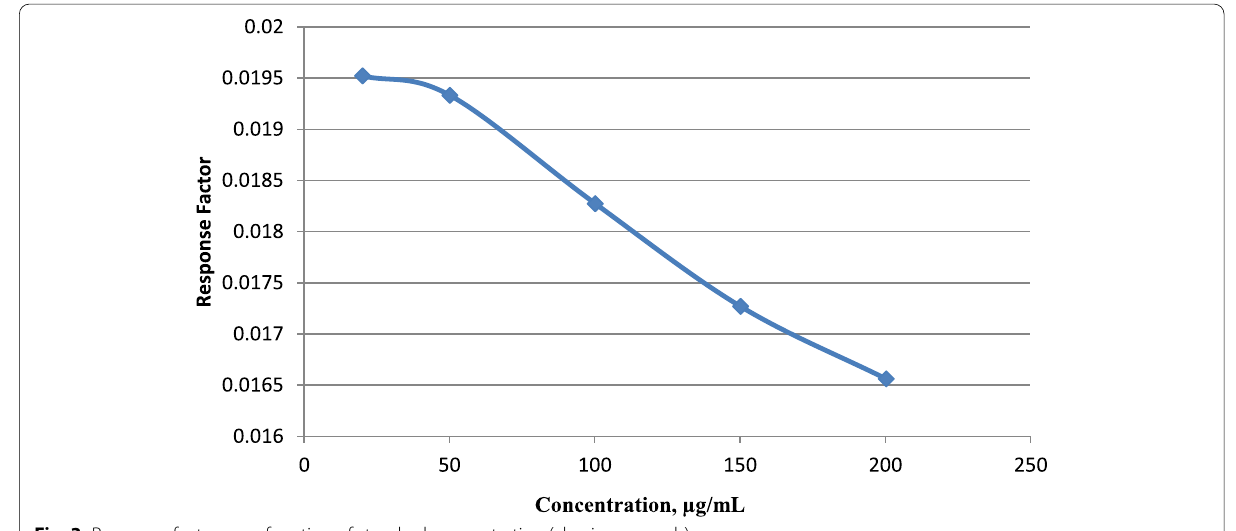
Fig. 3 Response factors as a function of standard concentration (classic